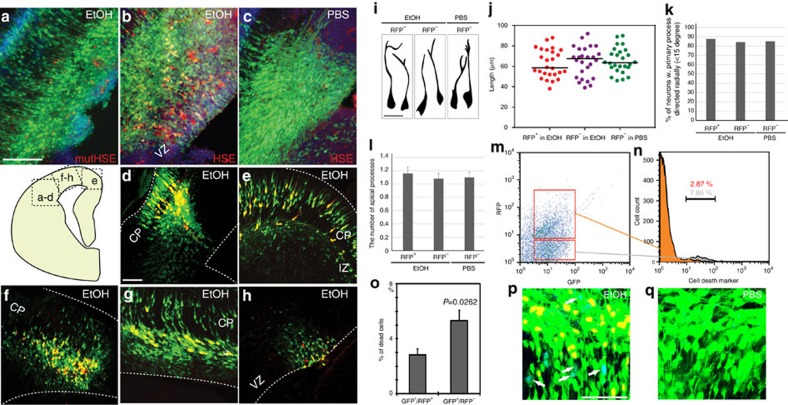
Normal development of HSE–RFP reporter+ neurons and increased cell death of reporter− cells in IUE-based reporter analysis.(a–c) pHSE- (b,c) or pmutHSE- (a) RFP was electroporated with pCAG–GFP into the mouse (C57NL/6J) lateral cortex at E14, followed by daily EtOH (a,b) or PBS (control, c) administration to the dam until E16. The reporter expression (red) was observed in NPCs and neurons by electroporation of p HSE–RFP followed by EtOH administration (b). Electroporation of pmut HSE–RFP plasmid that contains point mutations in HSF1 binding sites in the promoter (Supplementary Fig. 3) resulted in reporter expression in less than 0.1% of total electroporated (GFP+) cells in the cortex exposed to EtOH (n=22). Similarly, electroporation of p HSE–RFP in Hsf1 KO mice resulted in no reporter induction by EtOH exposure (n=3/3). (d–h) The HSE–RFP reporter expression was observed in NPCs and neurons throughout the cortex, including lateral (d), medial (e) and dorsal (f–h) regions. CP: cortical plate, IZ; intermediate zone, VZ: ventricular zone. Scale bar, 250 μm. (i) Normal morphology of HSE–RFP + neurons in IUE approach. Representative morphologies of RFP+/GFP+ and RFP−/GFP+ neurons in the CP exposed to EtOH or PBS (control) as indicated. (j) The length of the primary process was plotted for neurons in the indicated groups, showing no significant differences between the groups. (k) The percentage of neurons with a radially-directed (<15 degrees) primary process. (l) The number of apical processes was quantified for neurons in the indicated groups. No significant differences were found between the groups. (m–o) Flow cytometric analysis of the electroporated cells (m), revealed that HSE–RFP + cells (orange in n) contain less dead cells than HSE–RFP− cells (gray in n) in the cortex exposed to EtOH. The mice were electroporated with p HSE–RFP and pCAG–GFP at E14 followed by daily EtOH administration until E16. Cells were then dissociated and stained with a cell death marker (7-AAD). (o) Percentages of the cells positive for cell death marker in HSE–RFP -positive and –negative cells. P<0.01 by t-test (n=7 embryos). (p,q) Consistent with the data quantified with 7-AAD (m–o), activated Caspase-3 (blue) is observed frequently in HSE–RFP−/GFP+ electroporated cells (p, shown in white arrows), but not in HSE–RFP+/GFP+ in EtOH (p) or HSE–RFP−/GFP+ in PBS-exposed (q) cortices. Scale bar, 50 μm.